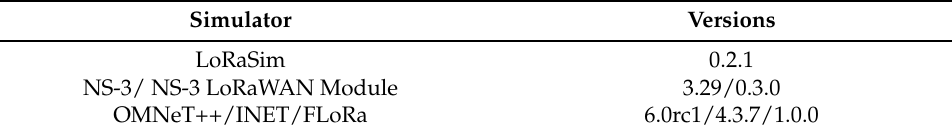
Table 11. Simulators